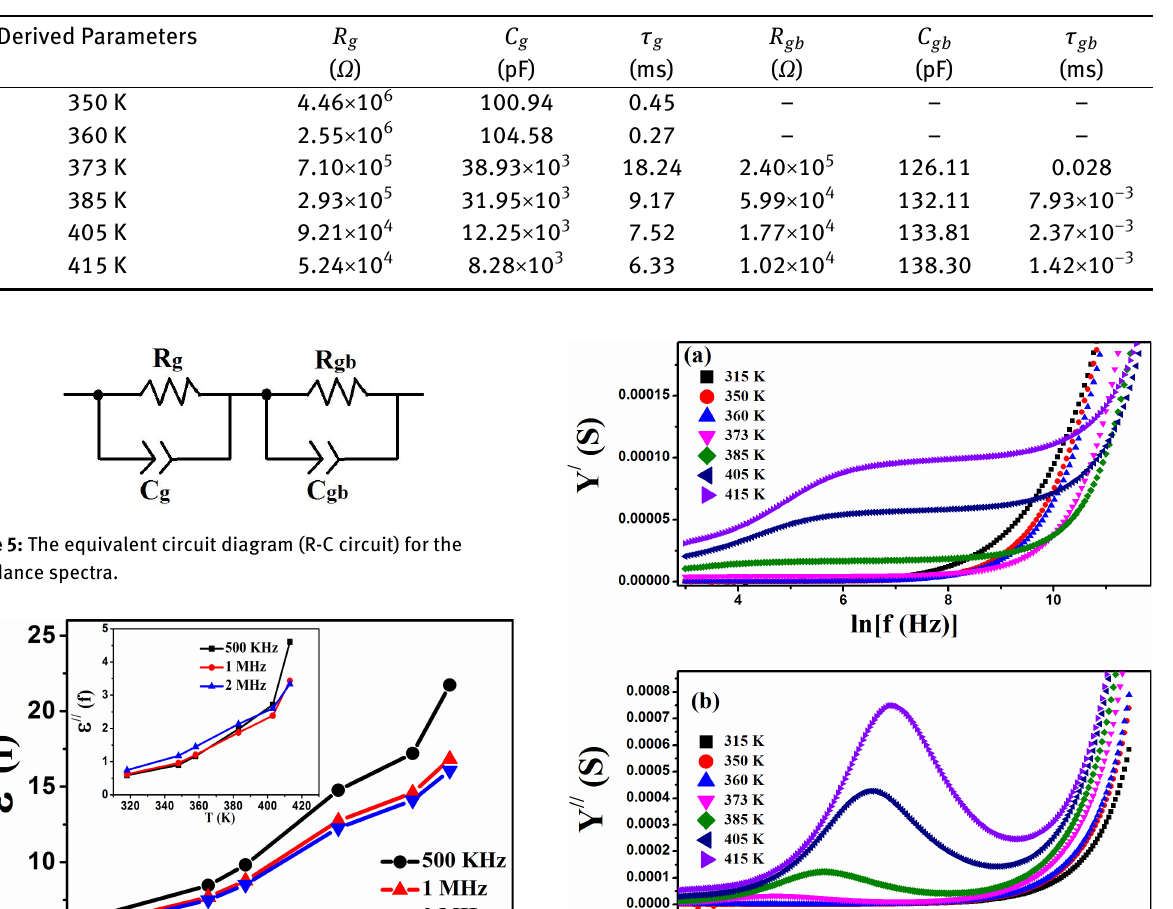
Table 2: Derived electrical parameters (grain resistance, grain boundary resistance, grain capacitance, grain boundary capacitance, grain relaxation time, grain boundary relaxation time) from Nyquist plot.